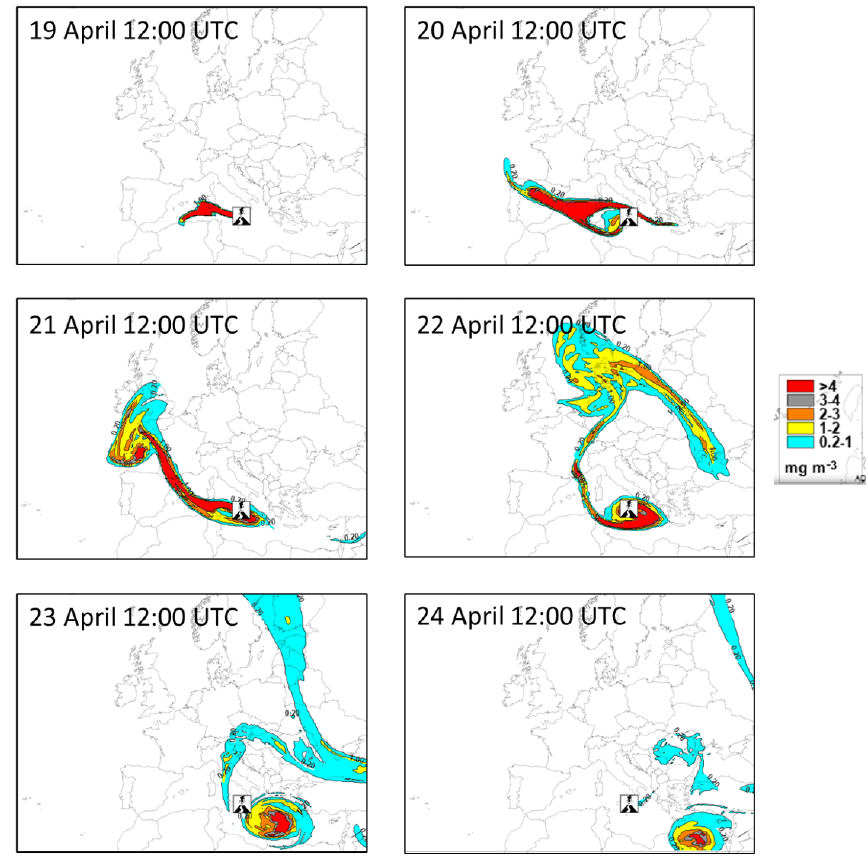
Figure 10. Model ensemble (75th percentile) for the 6 consecutive days after the artificial Etna eruption in April 2018. The data are depicted at